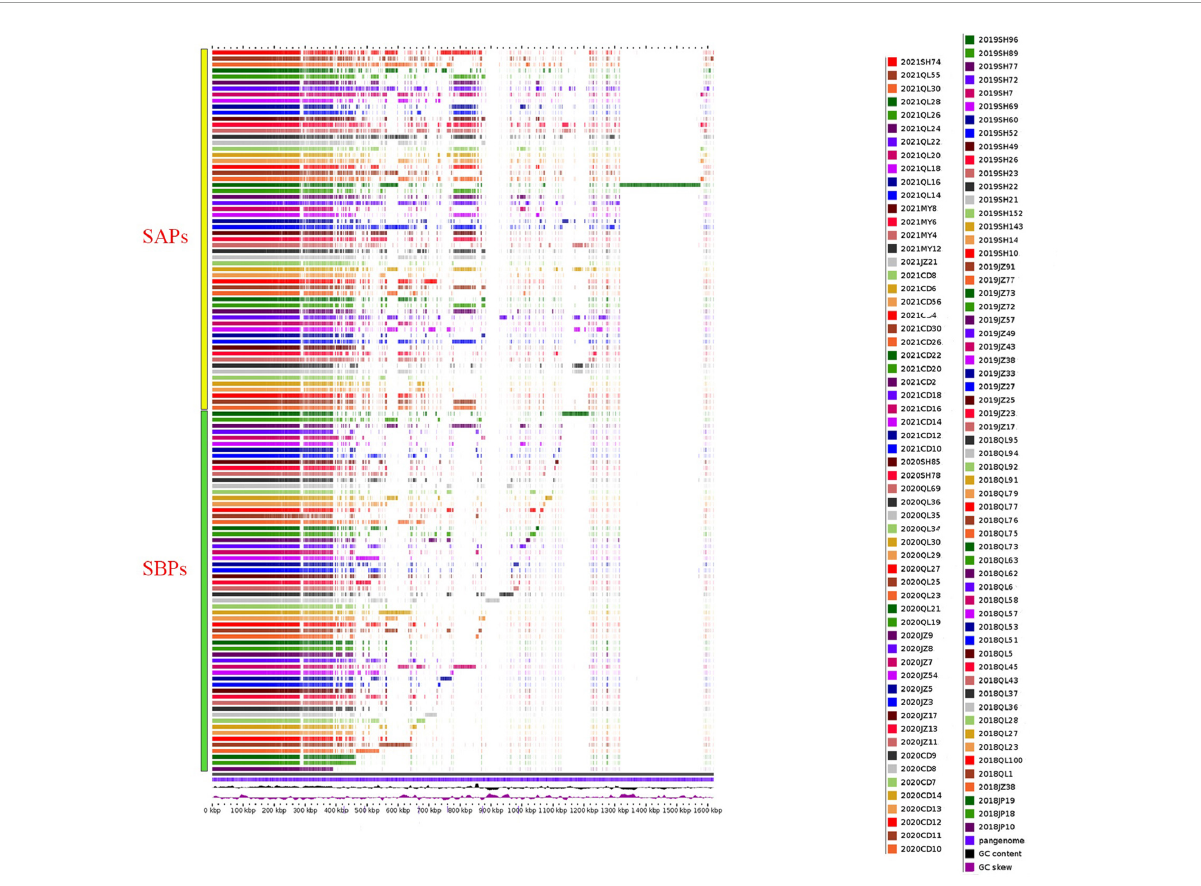
FIGURE5 Pan-genomic analysis of 120 Campylobacter strains of porcine origin. Each row represents the sequence of one strain. Yellow: SAPs, green: SBPs. Pan-genome, GC content, and GC skew are indicated by blue-purple, black, and purple at the